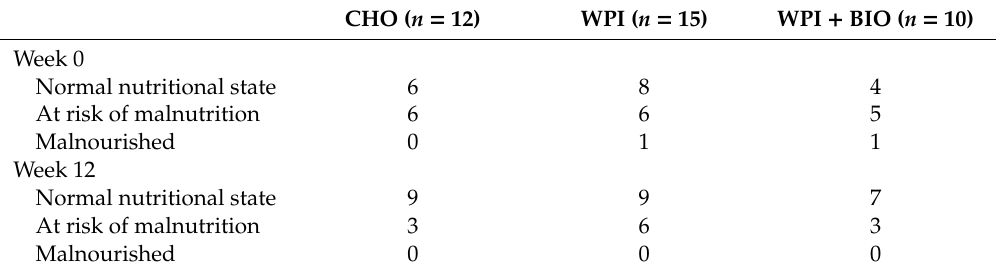
Table 5. Number of elderly subjects with limited mobility classified at normal nutritional state, at risk of malnutrition or malnourished with the Mini Nutritional Assessment (MNA ® ) before and after treatment with a combination of EMS and nutritional supplement: CHO, WPI or WPI + BIO for 12